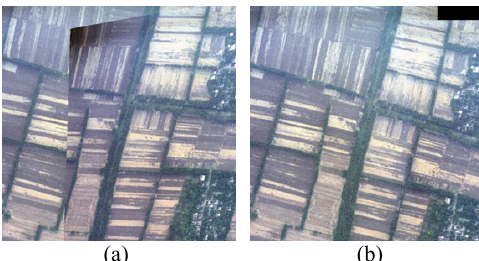
Figure 2. (a) Mosaic effect before the mismatch points elimination, (b) mosaic effect after the mismatch points